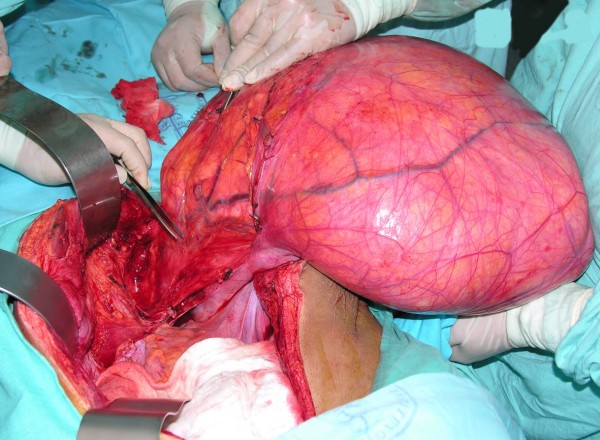
Retroperitoneal tumor (80 × 60 cm), weighing 18 kg. Complete resection.